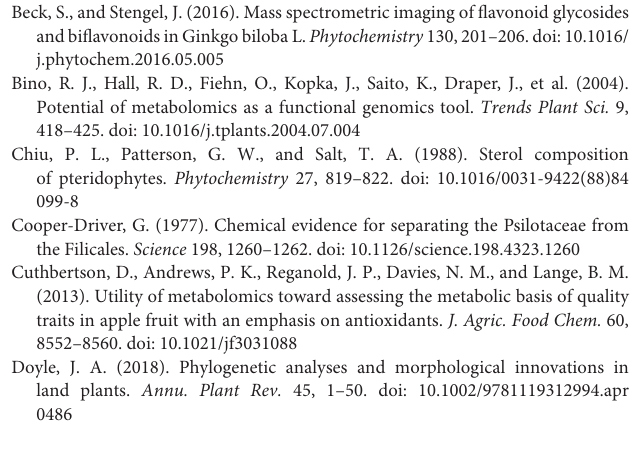
TABLE S4 | NMR acquisition